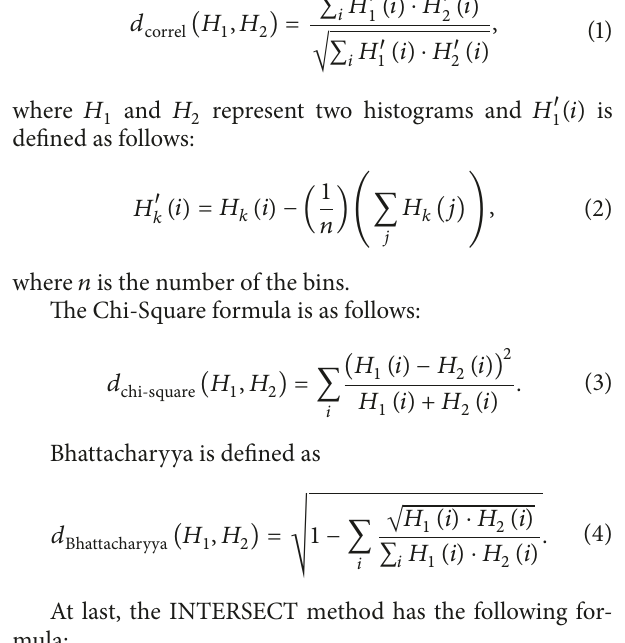
Algorithm 1: Key-frame